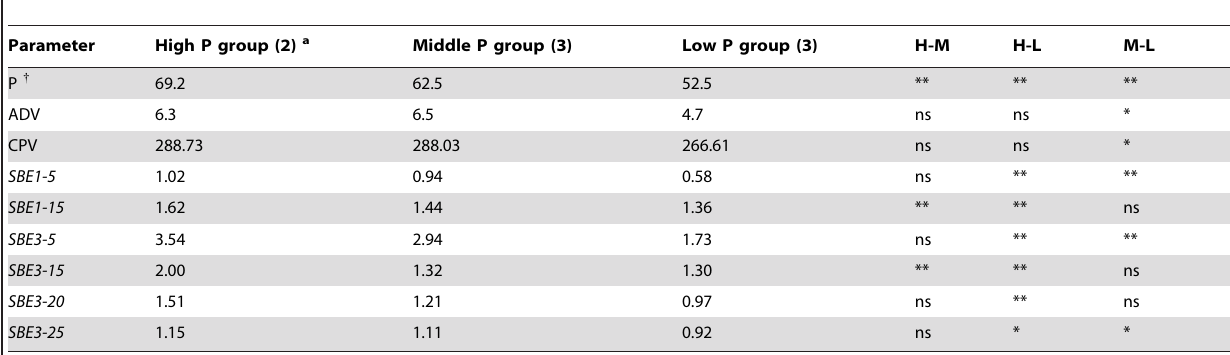
Table 5. mRNA expressions of SBE1 and SBE3 related to eating quality properties among high, middle, and low palatability groups.